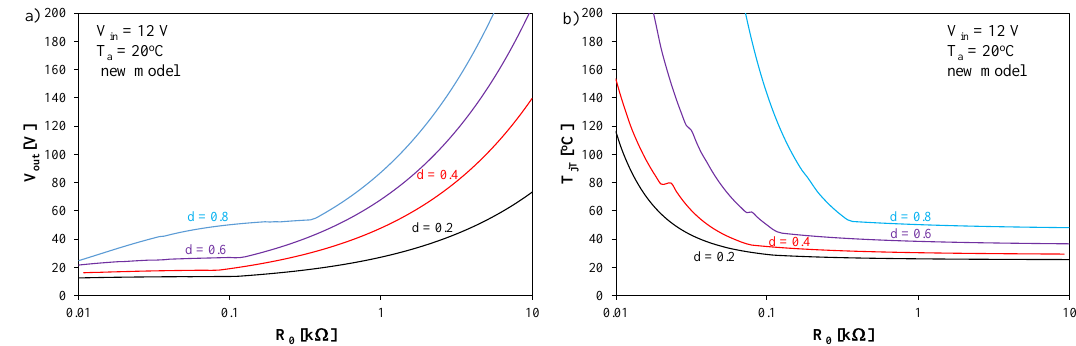
Figure 19. Computed dependences of converter output voltage ( a ) and internal temperature of IGBT ( b ) on load resistance for selected values of duty cycle.